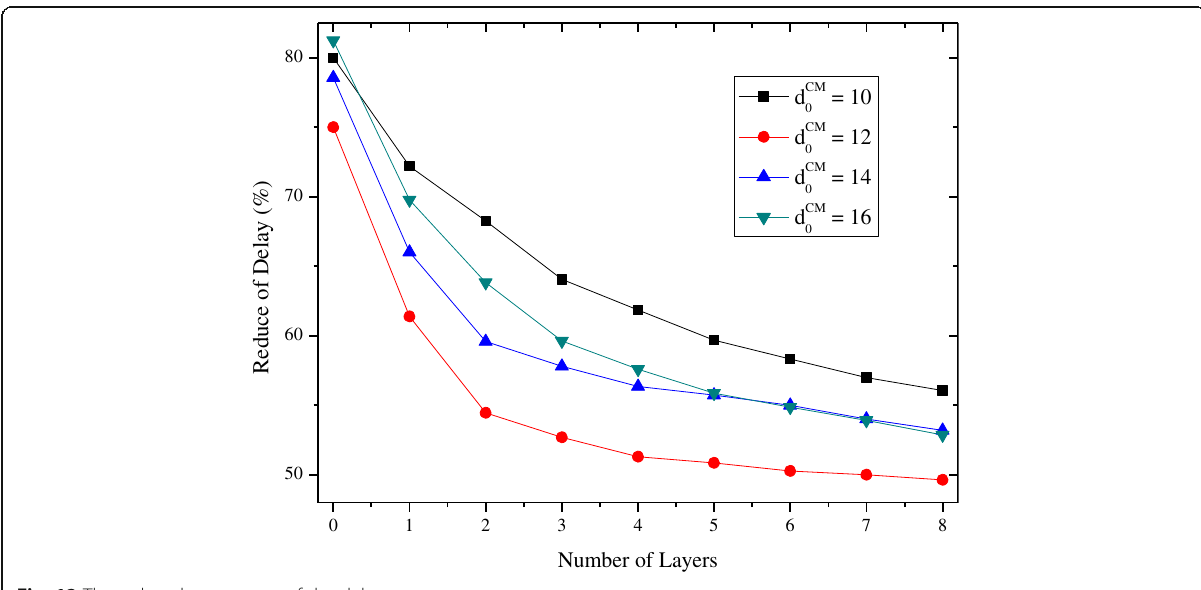
Fig. 12 The reduced percentage of the delay